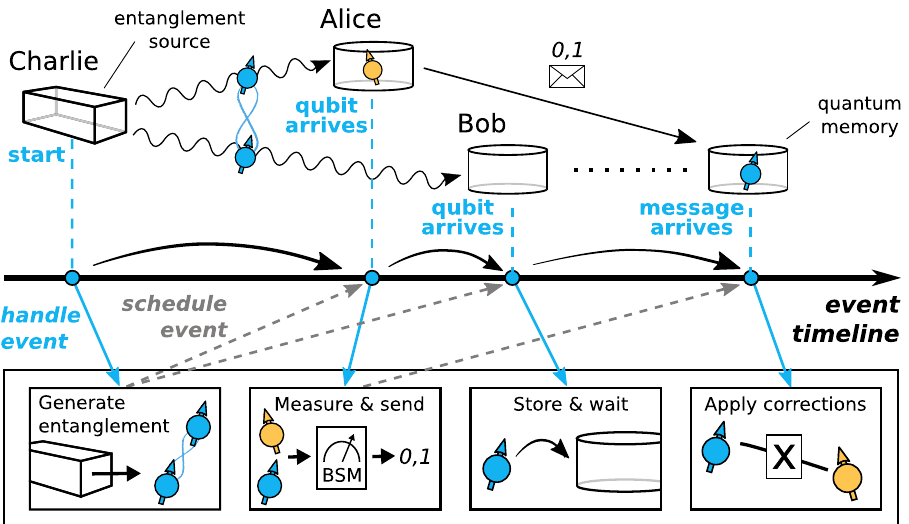
Fig. 2 Abstract example of simulating a quantum protocol with discrete events. When setting up the simulation, protocol actions are de fi ned to occur when a speci fi c event occurs, as in the setup of a real system. Instead of performing a continuous time evolution, the simulation advances to the next event, and then automatically executes the actions that should occur when the event takes place. Any action may again de fi ne future events to be triggered after a certain (stochastic) amount of time has elapsed. For concreteness a simpli fi ed quantum teleportation example is shown where a qubit, shown as an orange circle with arrow, is teleported between the quantum memories of Alice and Bob. Here, entanglement is produced using an abstract source sending two qubits, shown as blue circles with arrows, to Alice and Bob. Once the qubit has traversed the fi bre and reaches Alice ’ s lab, an event is triggered that invokes the simulation of Alice ’ s Bell state measurement (BSM) apparatus. The simulation engine steps from event to events de fi ned by the next action, which generally occur at irregular intervals. This approach allows time-dependent physical non-idealities, such as quantum decoherence, to be accurately